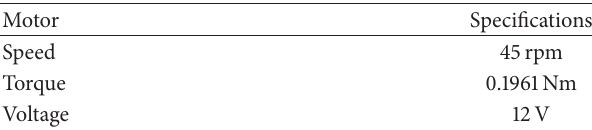
Figure 1: Omnidirectional wheel.